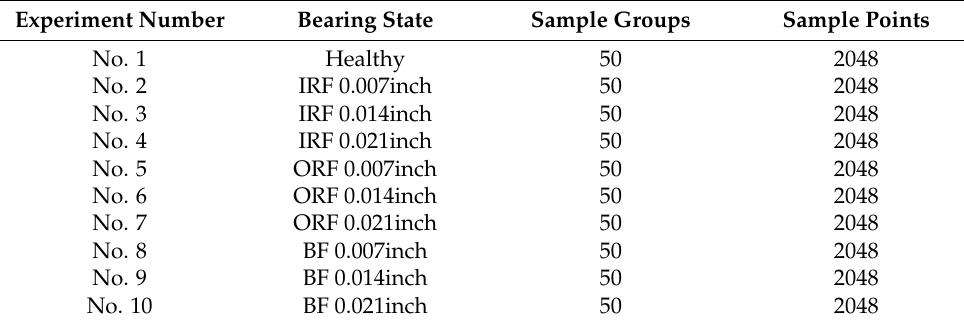
Table 3. Experimental parameter settings under different fault